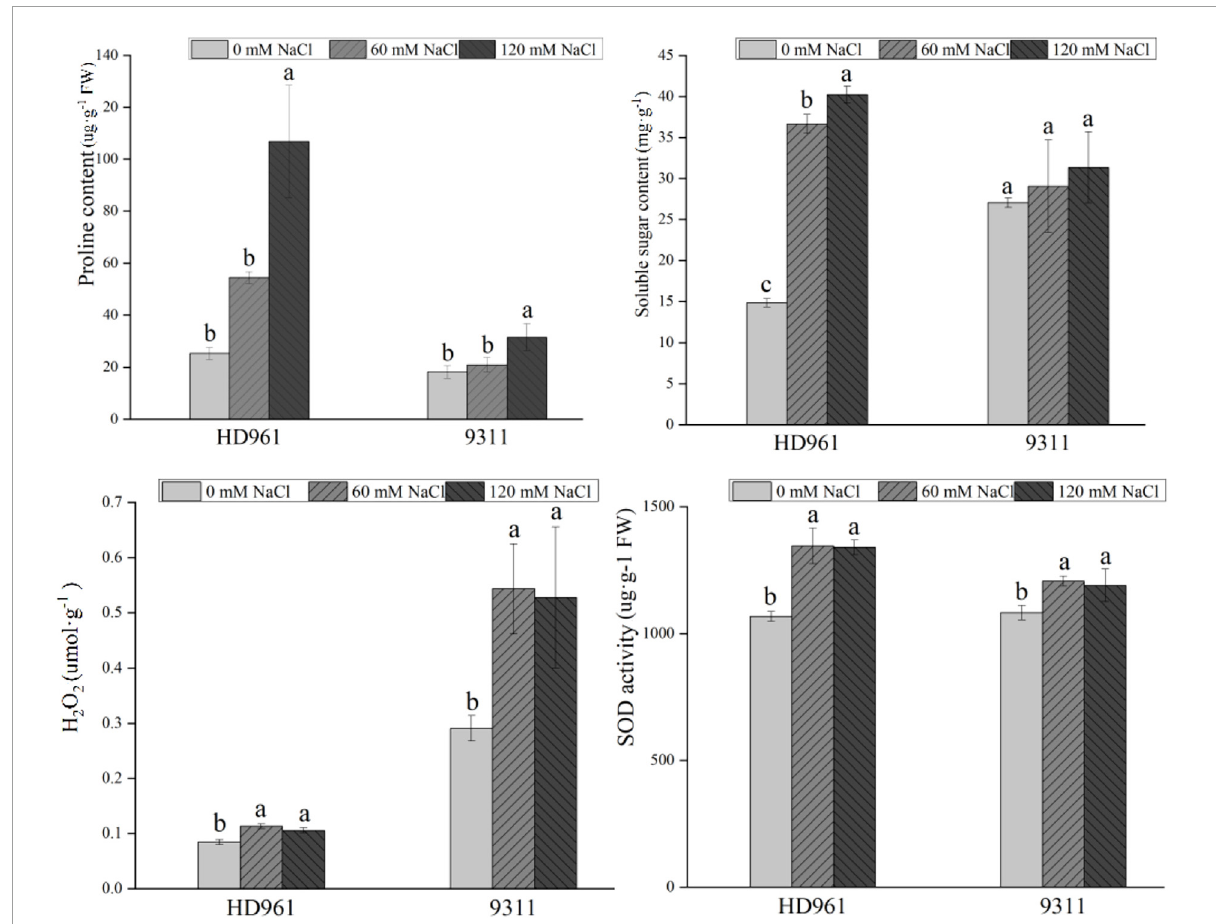
FIGURE1 Physiologic parameters of HD961 and 9311 after 7-day salt stress treatment. The values of the error bars are plus and minus standard deviation values. The different letters denote that it is at the significance level among different concentrations of the same cultivar, p <